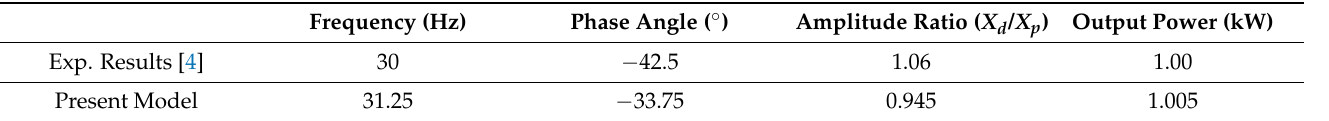
Table 3. FPSE validation.